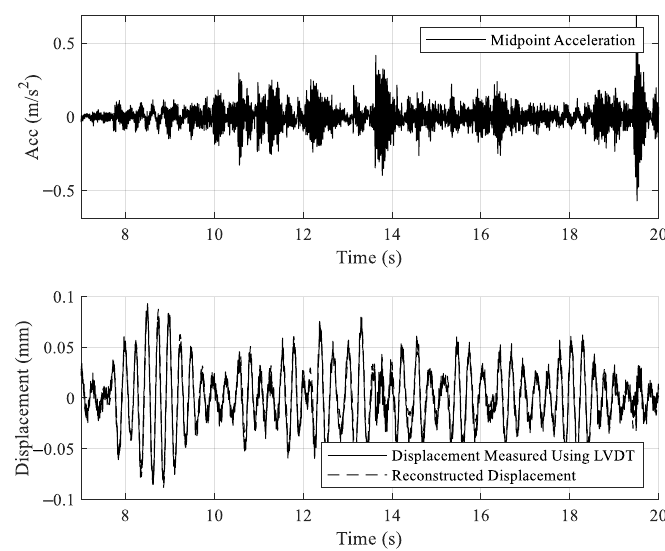
Figure 14. L inear variable differential transformers (LVDT) displacements and reconstructed displacements (bottom) from accelerations (top) on scenario LVB0S1.